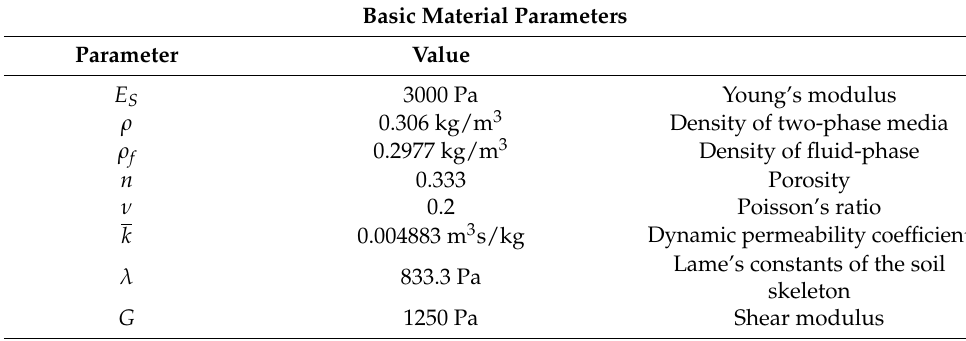
Table 1. Parameters of linear elastic saturated soil.